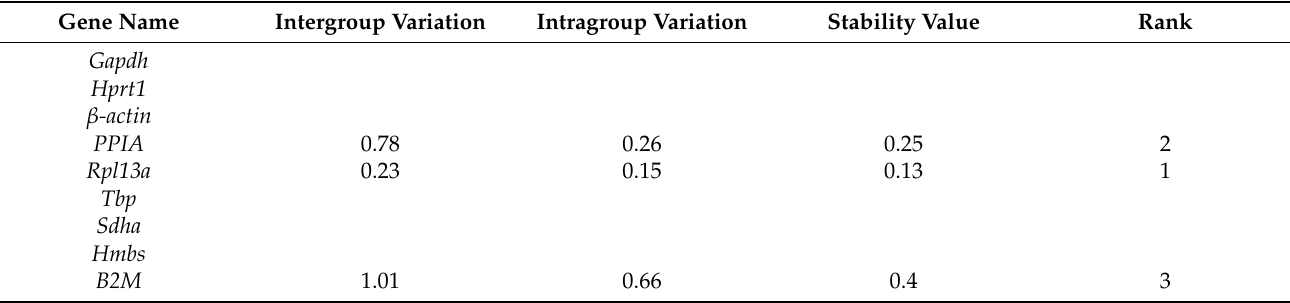
Table 7. Expression features in female hypothalamus tissues at different developmental stages analyzed by